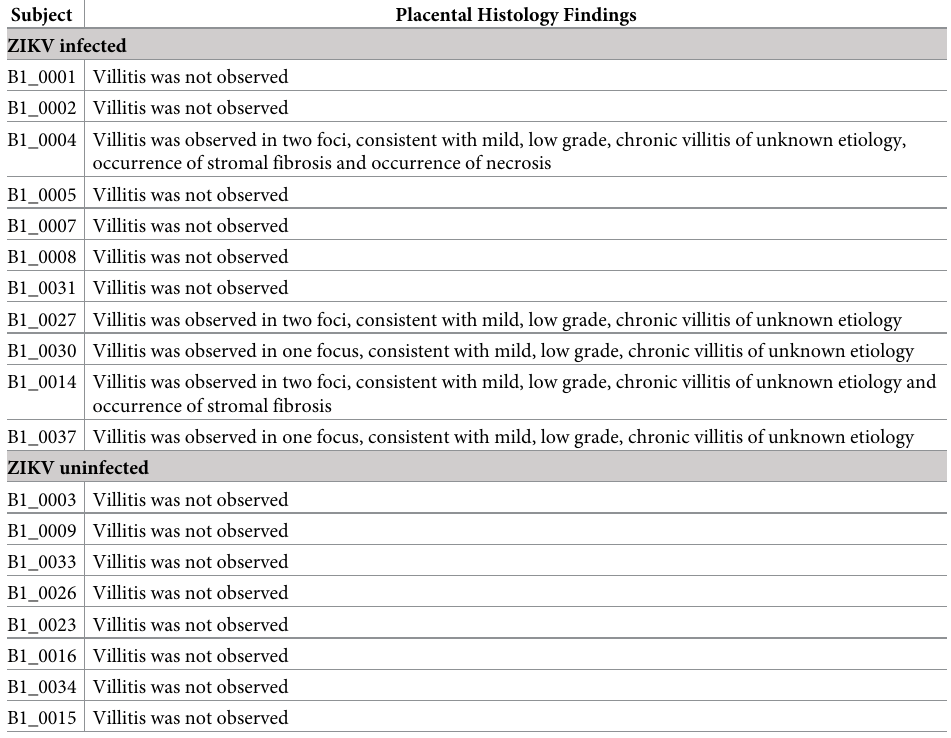
Table 3. Placental pathology. In 5 of 11 ZIKV-infected cases, focal villitis was observed as defined by less than 10 villi per focus.